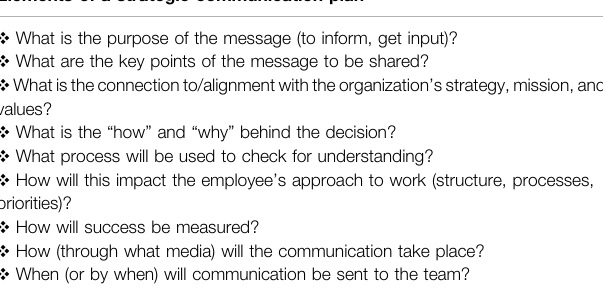
TABLE 1 | Elements of a strategic communication